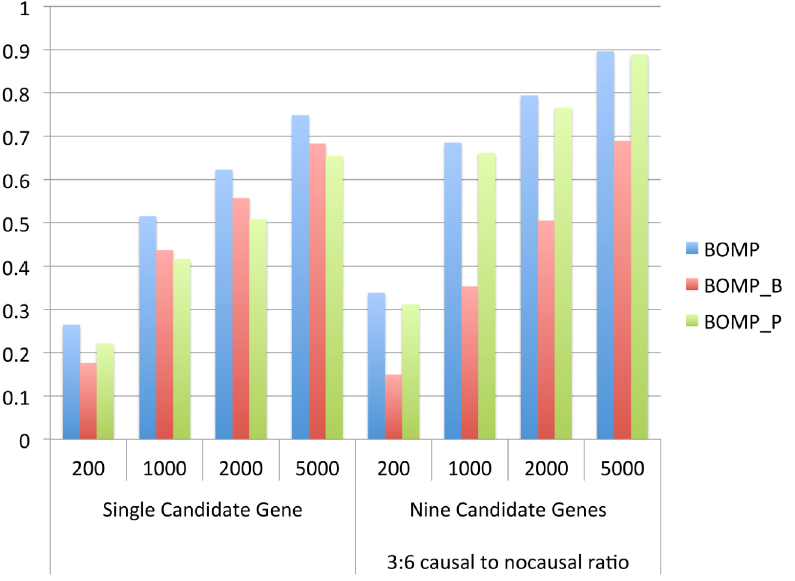
Figure 5. BOMP burden and position statistics complement each other. Breakdown of contribution of BOMP mutation burden (BOMP_B) and BOMP position distribution (BOMP_P) statistics averaged over single candidate gene power estimates (Figure 1) and multiple candidate gene power estimates (nine genes, 3 with causal variants and 6 with no causal variants) (Figure 3) for case-control study sizes of 200, 1000, 2000, and 5000. Combining the two statistics consistently yielded improved power with respect to each statistic on its own. The BOMP burden statistic had more power than BOMP position for the simulations based on a single candidate gene, and vice versa in the simulations with nine candidate genes and 3:6 causal to non-causal ratio.